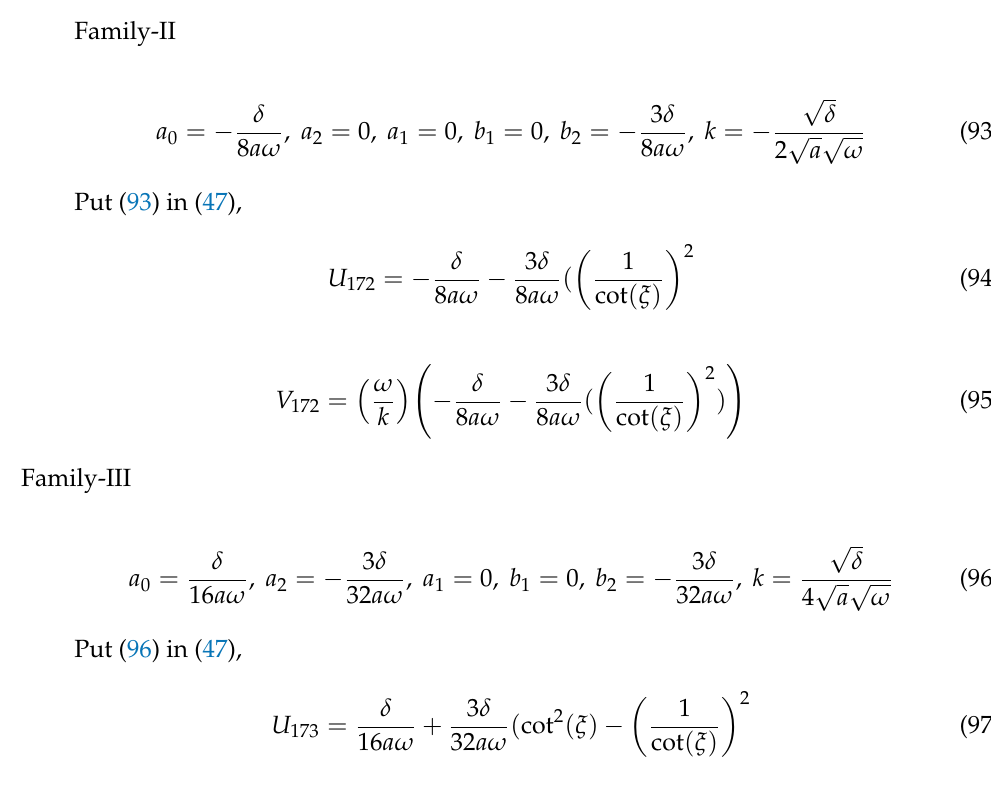
Figure 5. The profile of solutions U 163 ( a , b ) and V 163 ( c , d ) with α = 1, δ = 0.002, a = 2.1, ω = 0.5 and ( α = 1, δ = 2, a = 2.1, ω = 0.5